Question: Write a descriptive caption for this figure.
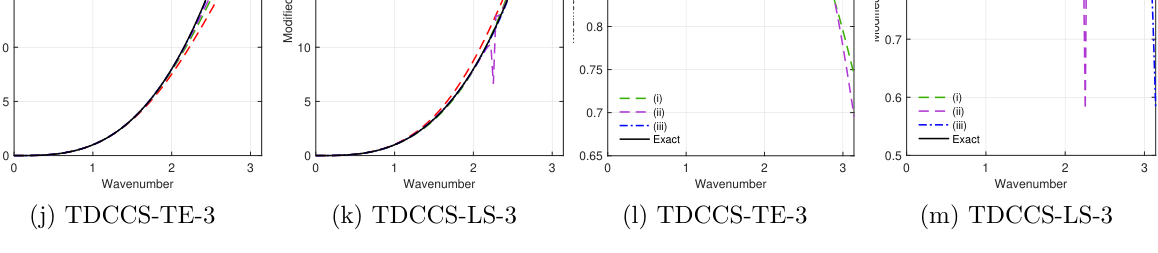
Answer: Plot of modified wavenumber versus wavenumber for (a) TDCCS-TE-1, (b) TDCCS-LS-1, (e) TDCCS-TE-2, (f) TDCCS-LS-2, (j) TDCCS-TE-3 and (k) TDCCS-LS-3: (i) T4; (ii) T6; (iii) T8; (iv) P10. Variations of the relative modified wavenumber factor Rω′′′ with wavenumber for (c) TDCCS-TE-1, (d) TDCCS-LS-1, (g) TDCCS-TE-2, (h) TDCCS- LS-2, (l) TDCCS-TE-3 and (m) TDCCS-LS-3:(i) T6; (ii) T8; (iii) P10.